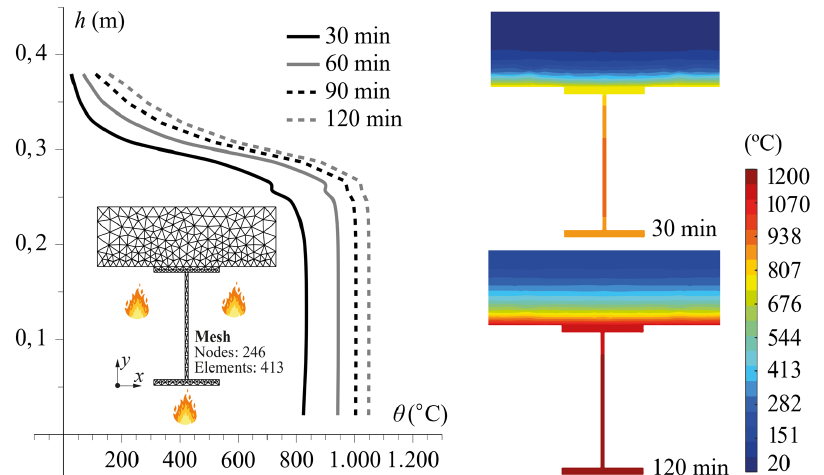
Figure 13. Temperature profile along the symmetry line of the problem and the two-dimensional thermal field for 30 and 120 min of exposure to fire.